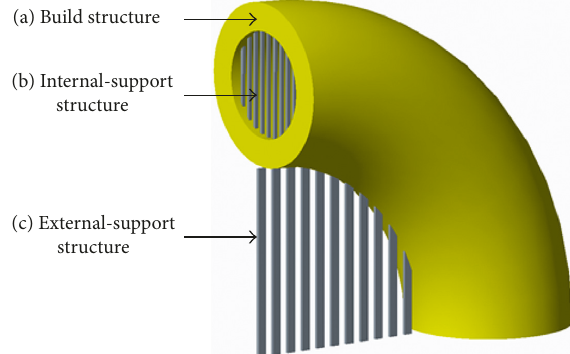
Figure 1: Schematic illustration of (a) build, (b) internal-support, and (c) external-support